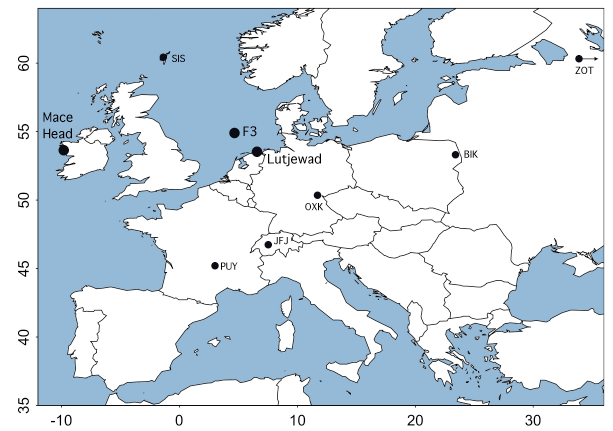
Figure 1 : Location of the three stations from which the flasks have been sampled: Fig. 1. Location of the three stations from which the flasks have Lutjewad, Mace Head and F3. Also shown are the locations of other European measurements which are used for comparison. These are: Ochsenkopf (OXK), been sampled: Lutjewad, Mace Head and F3. Also shown are the Bialystok (BIK), Shetland Islands (SIS), Zotino (ZOT), Puy de Dôme (PUY) and locations of other European measurements which are used for com- Jungfraujoch (JFJ). parison. These are: Ochsenkopf (OXK), Bialystok (BIK), Shetland Islands (SIS), Zotino (ZOT), Puy de Dˆome (PUY) and Jungfrau- joch